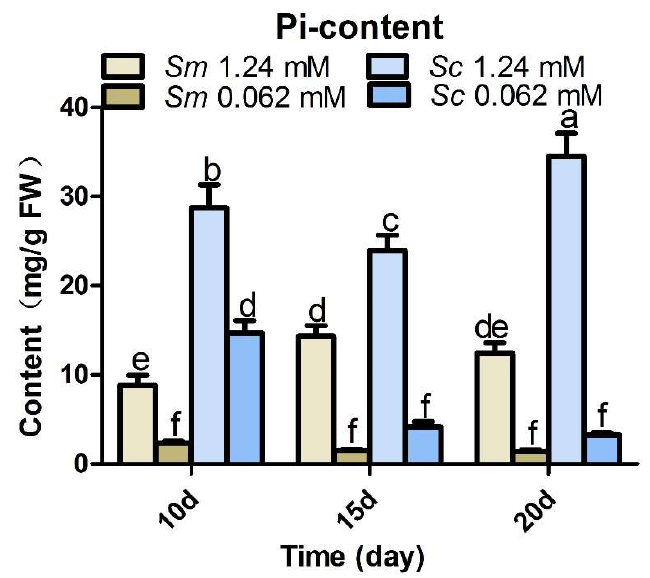
Figure 5. Pi concentration in hairy roots under control and Pi-deficient conditions. Sm , S. miltiorrhiza ; Sc , S. castanea ; different letters indicate significant differences by applying Duncan’s multiple range test.